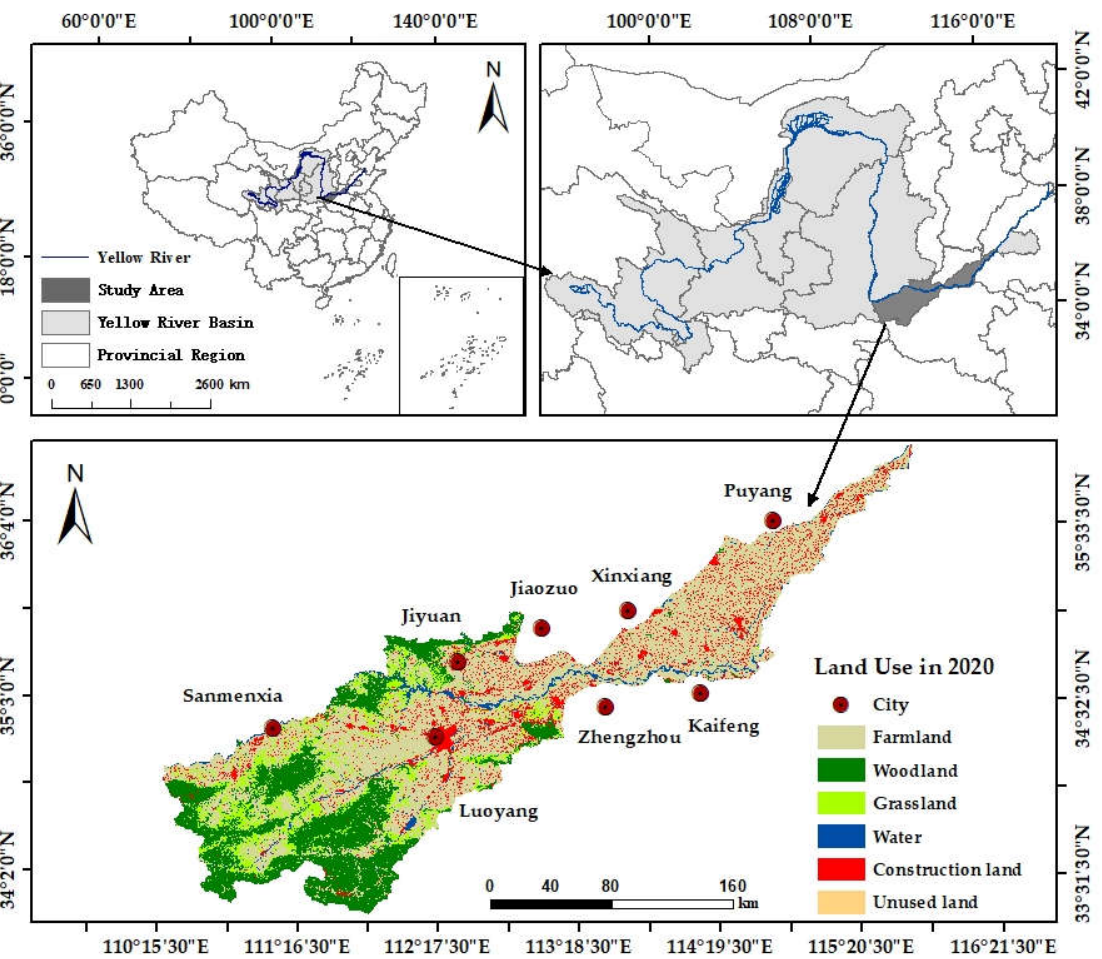
Figure 1. Schematic of the Yellow River Basin (Henan section). Notes: The data of land use cover in 2020 used in the figure was from Landsat 8 OLI remote sensing image data with a spatial resolution of 30 m.